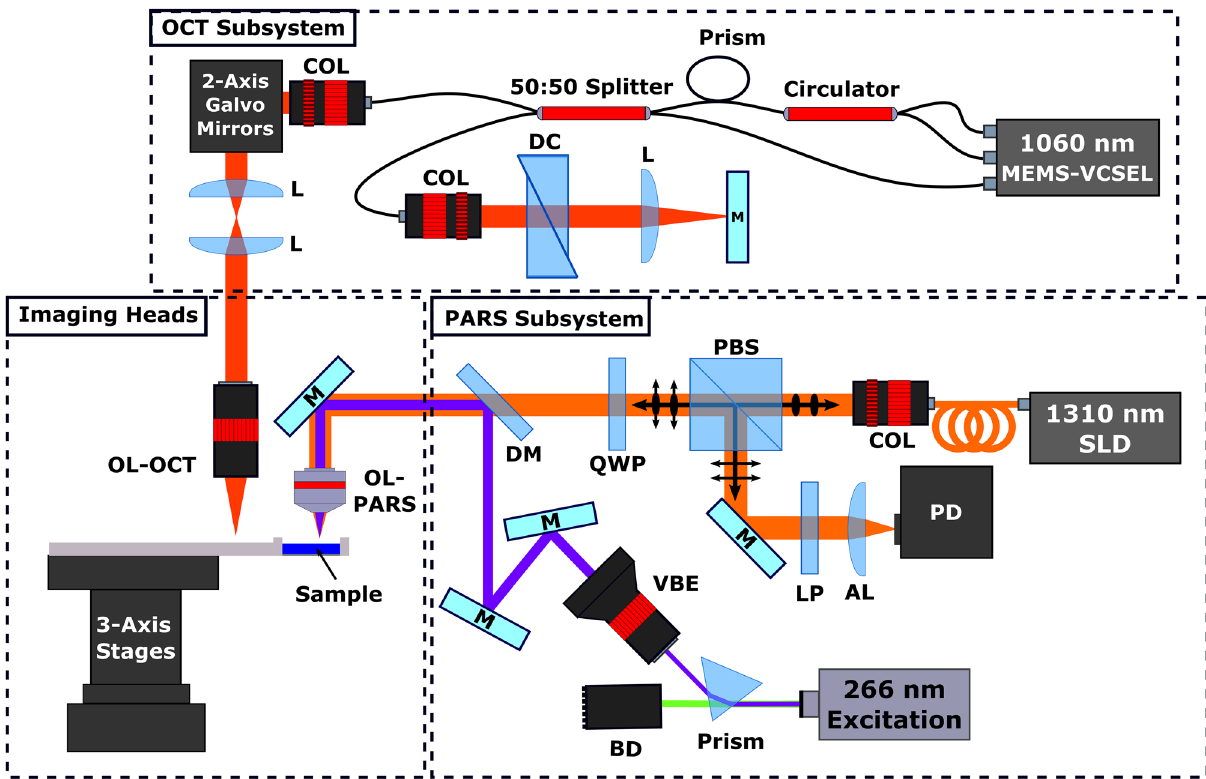
Figure 1. Simplified schematic of the combined OCT and PARS system. Component labels are defined as follows: OCT objective lens (OL-OCT), PARS objective lens (OL-PARS), collimator (COL), dispersion compensation (DC), lens (L), beam dump (BD), variable beam expander (VBE), polarizing beam splitter (PBS), quarter wave plate (QWP), dichroic mirror (DM), long pass filter (LP), aspheric focal lens (AL), photodiode (PD), 1310 nm super-luminescent diode (1310 nm SLD), mirrors